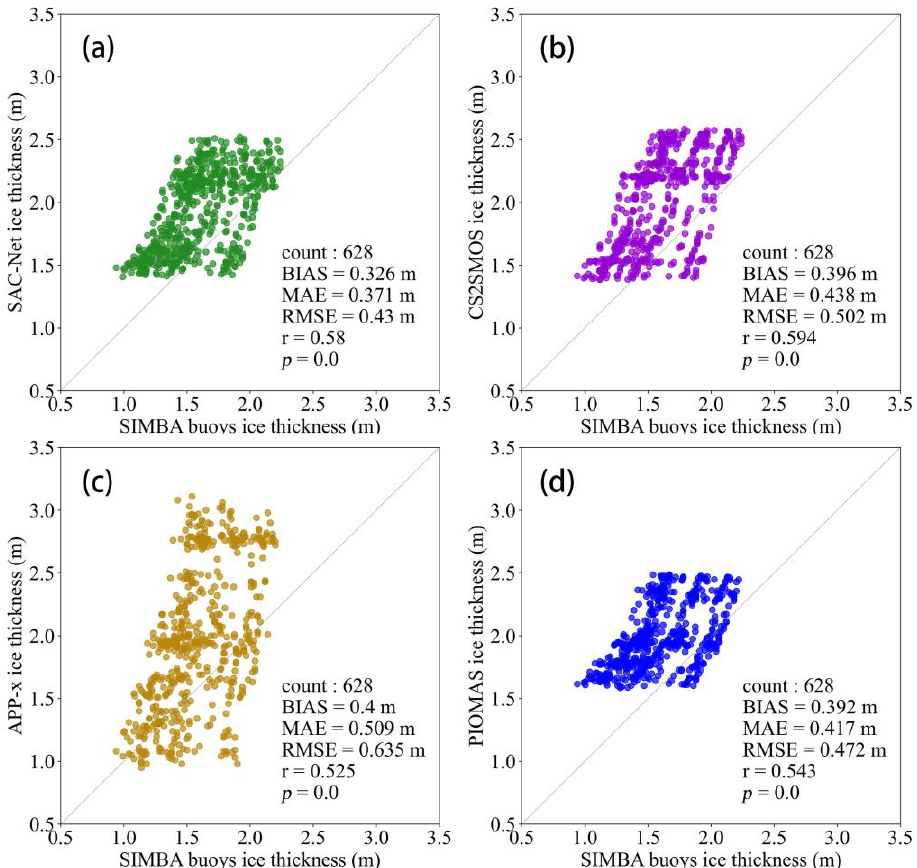
Figure 5. Statistical accuracy comparisons using 628 matched samples from SIMBA buoys, the proposed SAC-Net, CS2SMOS, APP-x, and PIOMAS SIT. ( a ) Scatter plot of SIMBA buoys SIT vs. SAC- Net SIT; ( b ) scatter plot of SIMBA buoys SIT vs. CS2SMOS SIT; ( c ) scatter plot of SIMBA buoys SIT vs. APP-x SIT; ( d ) scatter plot of SIMBA buoys SIT vs. PIOMAS SIT.